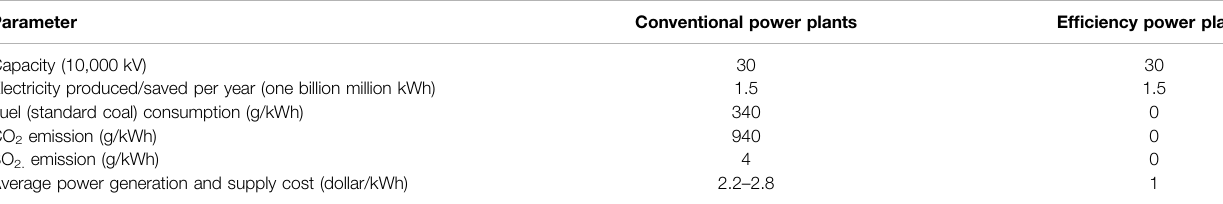
TABLE 1 | Comparison of conventional power plants and ef fi ciency power plants.